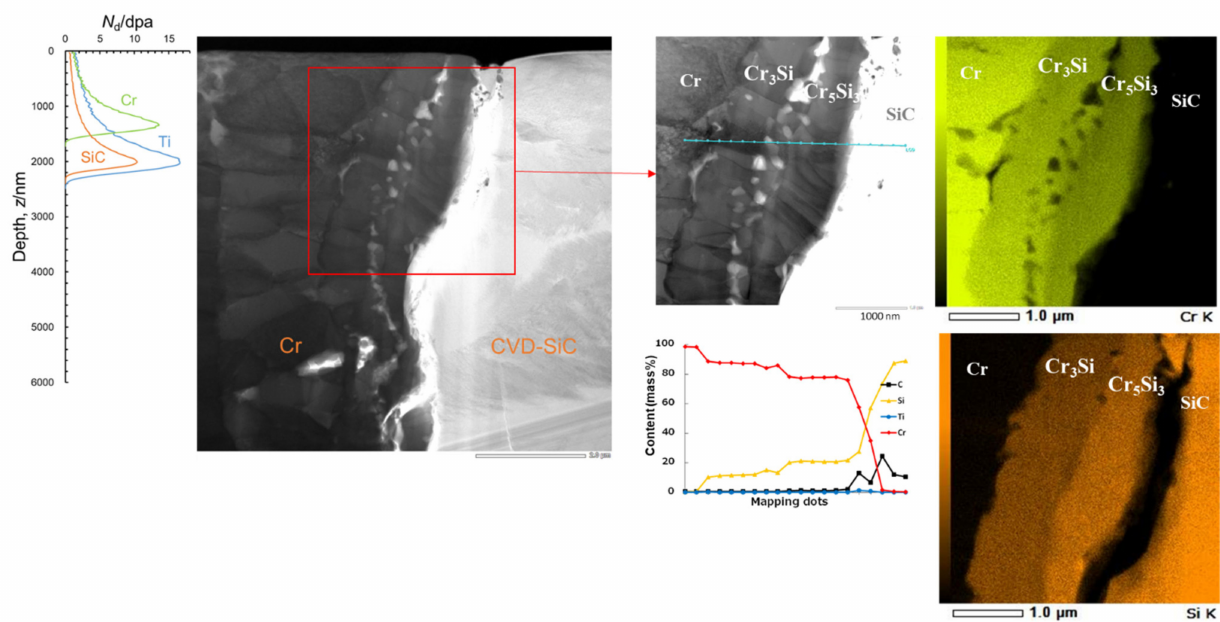
Figure 13. EDS line profiles and mappings of chemical composition across Cr/Cr 3 Si and Cr 3 Si/Cr 5 Si 3 phase interfaces in Ti-Cr multilayer coating after being irradiated with Si 2+ ions up to a fluence of 2.85 × 10 20 ions /m 2